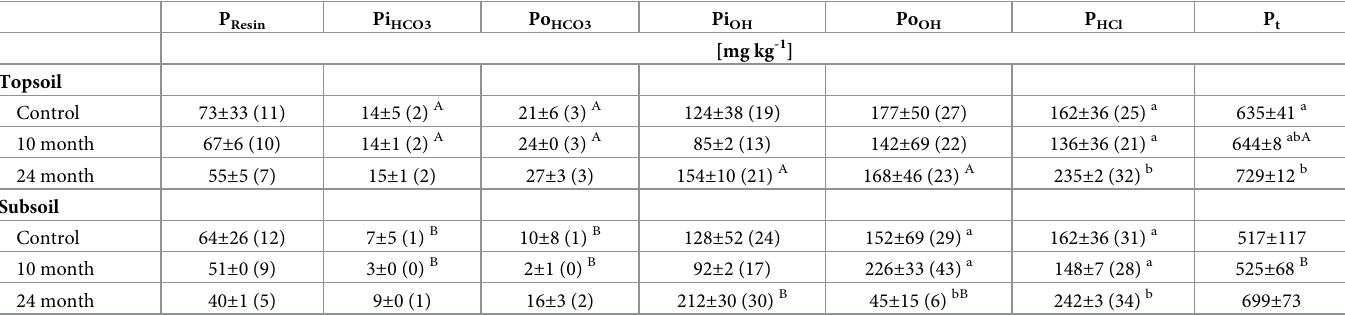
Table 4. Concentrations (mg kg -1 ) ± standard deviation of sequentially extracted phosphorus (P) fractions and proportions of total P (P t ) in parenthesis of the con- trol without clear-cut, 10, and 24 month after clear-cut. Different lowercase letters indicate significant ( P < 0 . 05 , n = 3) differences with time for top- or subsoil samples, respectively, whereas different uppercase letters indicate significant differences of top- and subsoil samples at the respective sampling time.